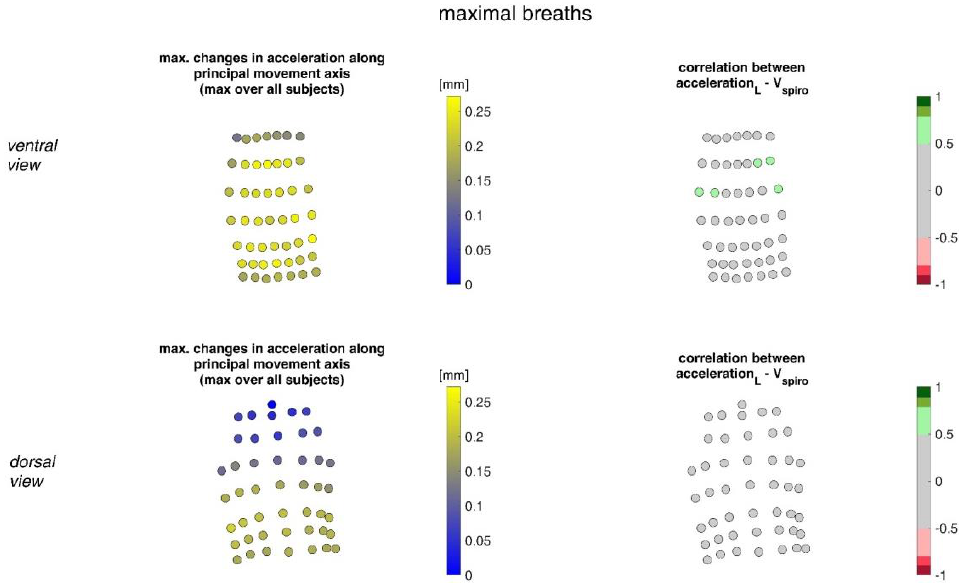
Figure 12. Illustration of the accelerations of MoCap markers along their main movement axis. The largest accelerations amongst all subjects (left) during maximal breaths and the mean corresponding correlation of maximal accelerations with spirometer volume V spiro of all subjects during maximal breaths are shown (right). (Top - ventral view, bottom - dorsal view).